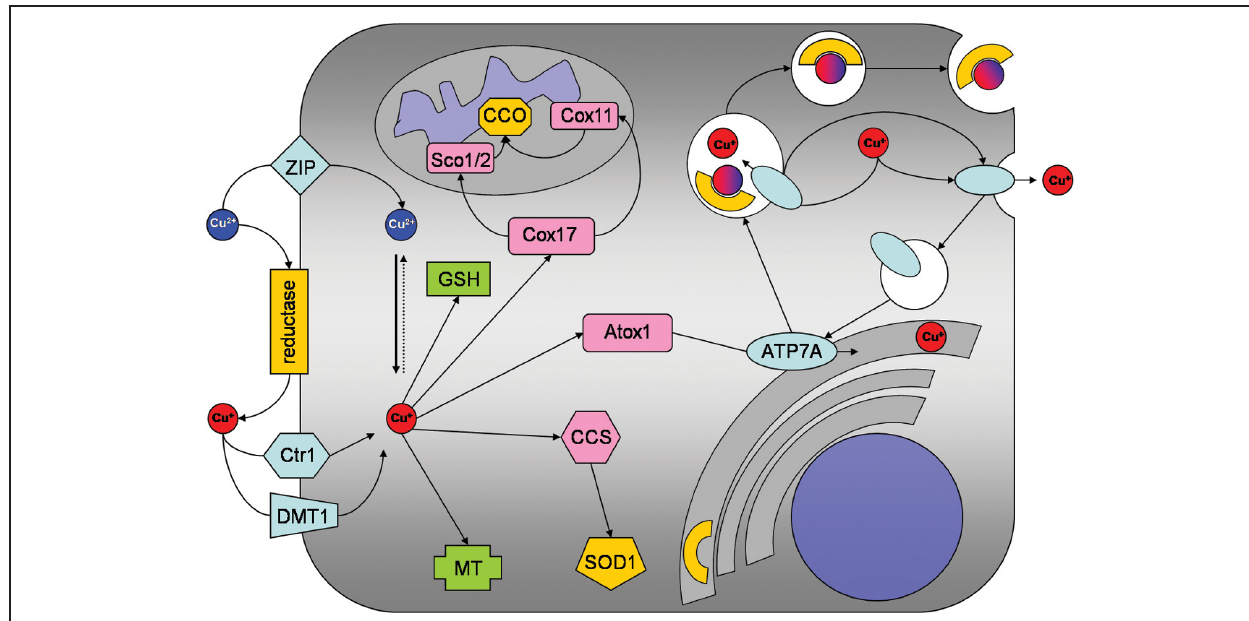
FIGURE 1 | Copper metabolism of astrocytes. Copper is taken up into astrocytes by the copper transporter receptor 1 (Ctr1) and also by Ctr1-independent mechanisms which may include the divalent metal transporter 1 (DMT1) or members of the ZIP family of metal transporters. An ecto-cuprireductase and/or extracellular ascorbate will provide the reduced copper species for astrocytic uptake by Ctr1 or DMT1. Accumulated copper is stored in astrocytes as complex with GSH or in metallothioneins (MT). In addition, copper is shuttled to its